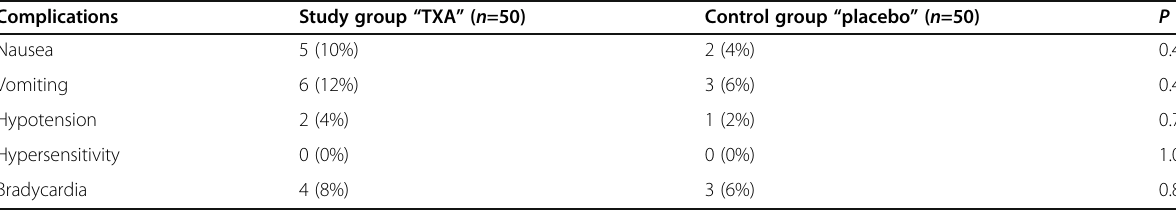
Table 9 Incidence of complications in the two groups